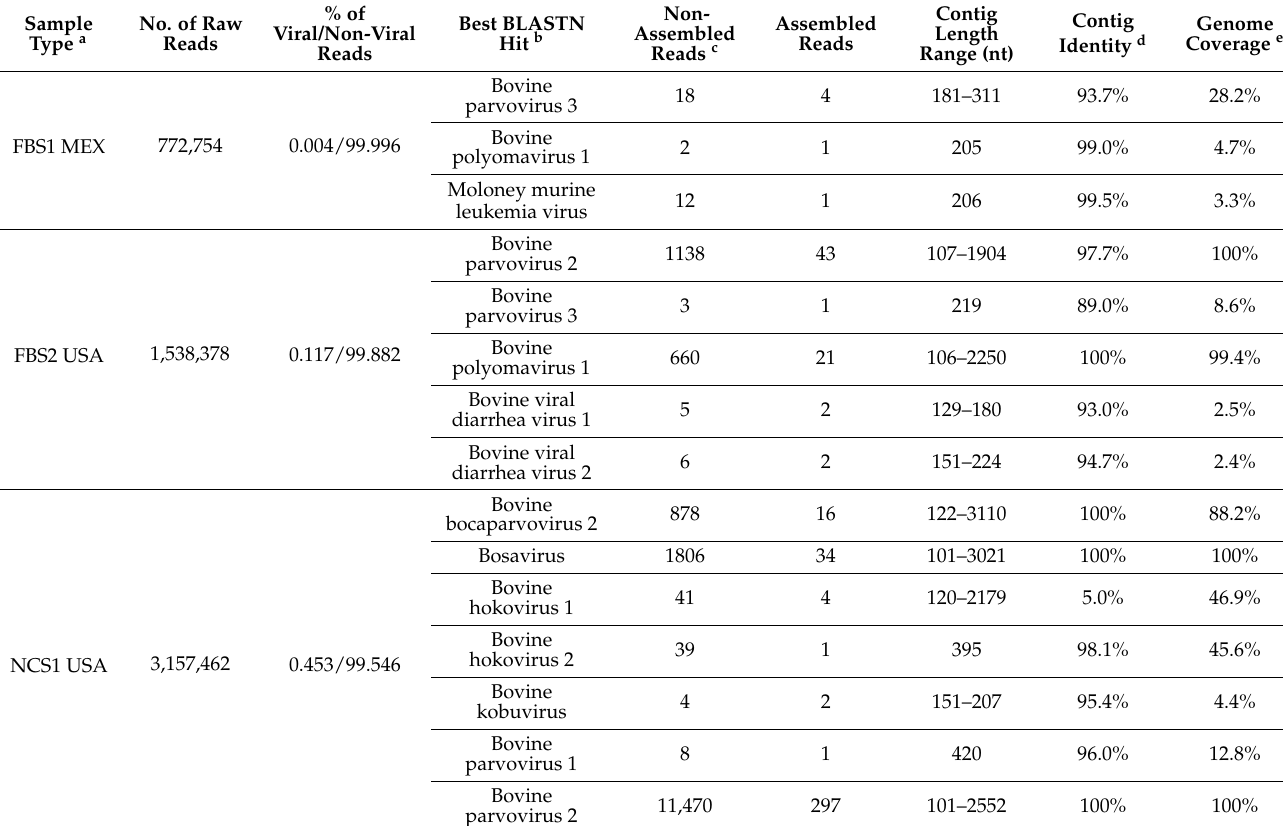
Table 1. Summary of sequences retrieved in the commercial batches of bovine serum that matched with eukaryotic viruses. Sample No. of Raw Type a